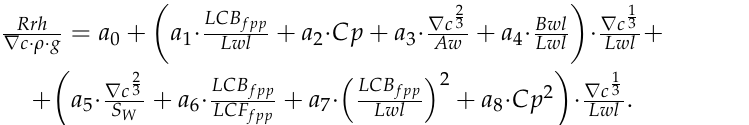
Figure 6. Structure of the curve of a section of the hull. To properly define the shape of all the curves of Figure 5, the designer can insert the values of the coordinates of the control points of the curves with the help of a user-inter- face as shown in the following Figures 7 and 8. The definition of the curves by means of the rational Bézier formulation is particularly suitable for the design of the hull of a sail- boat. In fact, once the main dimensions have been defined (e.g. max beam, max draught, length of water line), the designer can adjust the fullness of each curve without modifying the control polygon but just acting on the weights of the control points or the tangency at their ends.